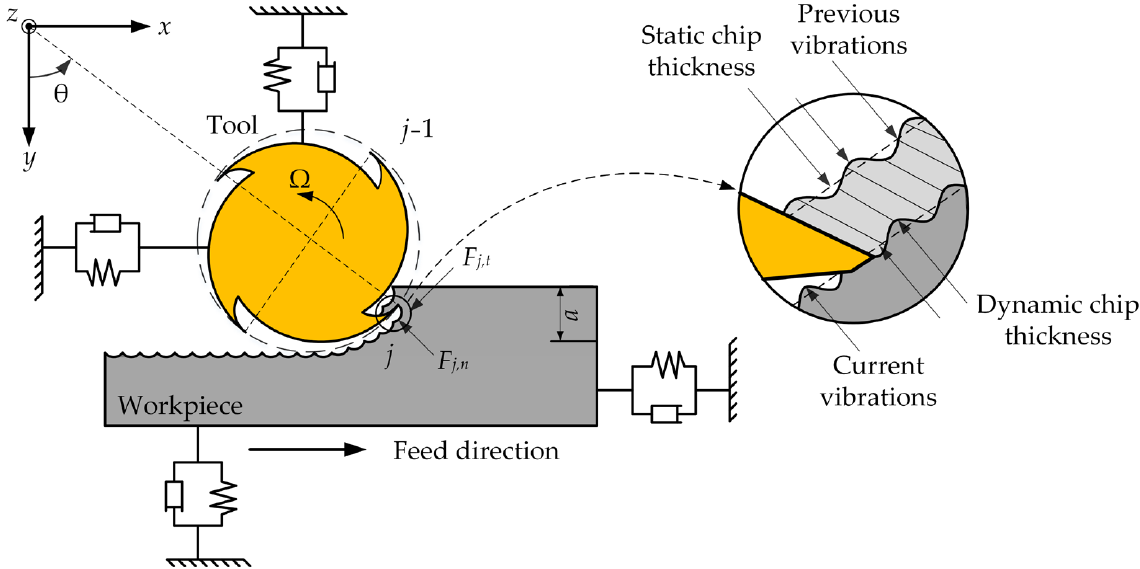
Figure 1. Dynamic milling dynamics model.